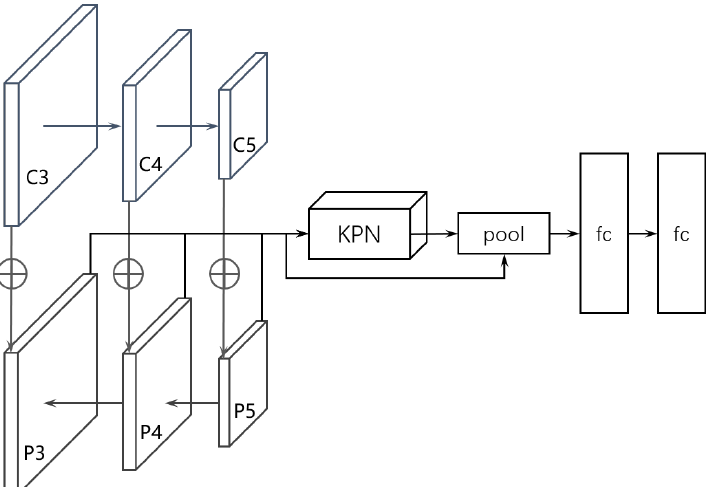
Figure 2. Real-time detection framework of CenterNet. The backbone outputs three feature maps, which are C3-C5, to connect a feature pyramid network (FPN). Then FPN outputs P3-P5 feature maps as the final prediction layers.